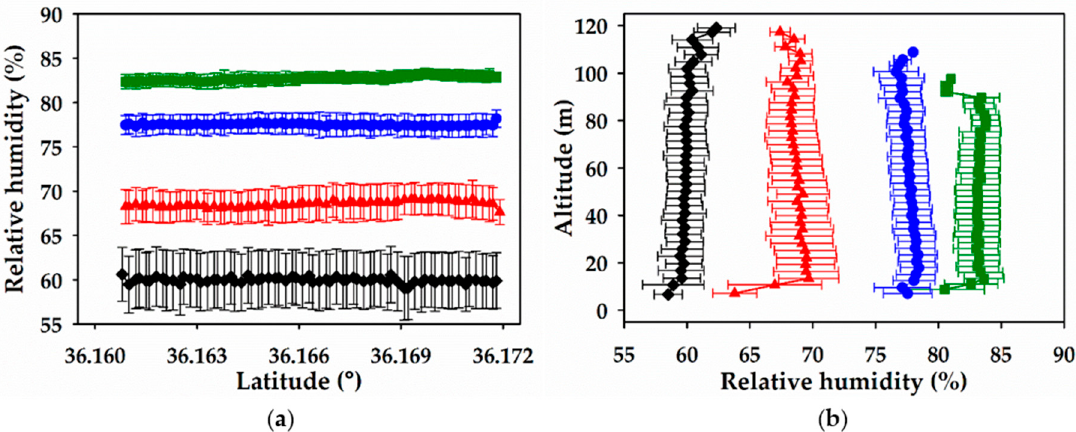
Figure 7. ( a ) The horizontal and ( b ) the vertical flight paths measuring relative humidity variations during the morning of 28 June, 2017 for the times (green square) 6:04–6:56 a.m. (UTC–5 h), (blue circle) 7:06–7:57 a.m. (UTC–5 h), (red triangle) 8:11–9:05 a.m. (UTC–5 h), and (black diamond) 9:28–10:22 a.m. (UTC–5 h).